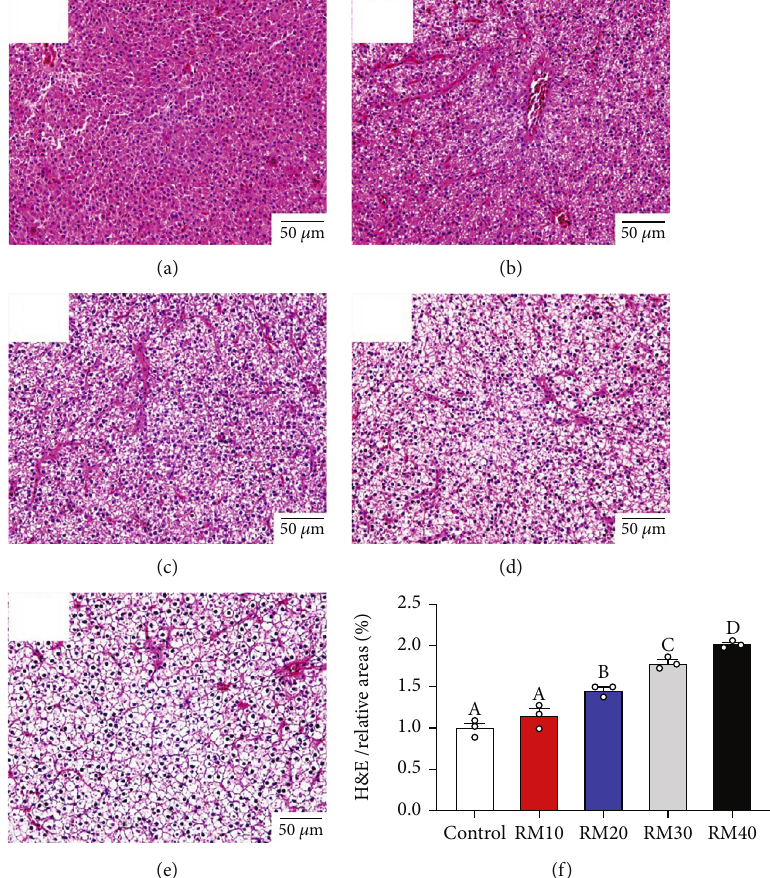
Figure 2: Liver tissue cross-sectional view of the fi ve groups (H&E staining, × 400). (a) The control. (b) RM10 group. (c) RM20 group. (d) RM30 group. (e) RM40 group. (f) Relative areas for hepatic vacuoles in H&E